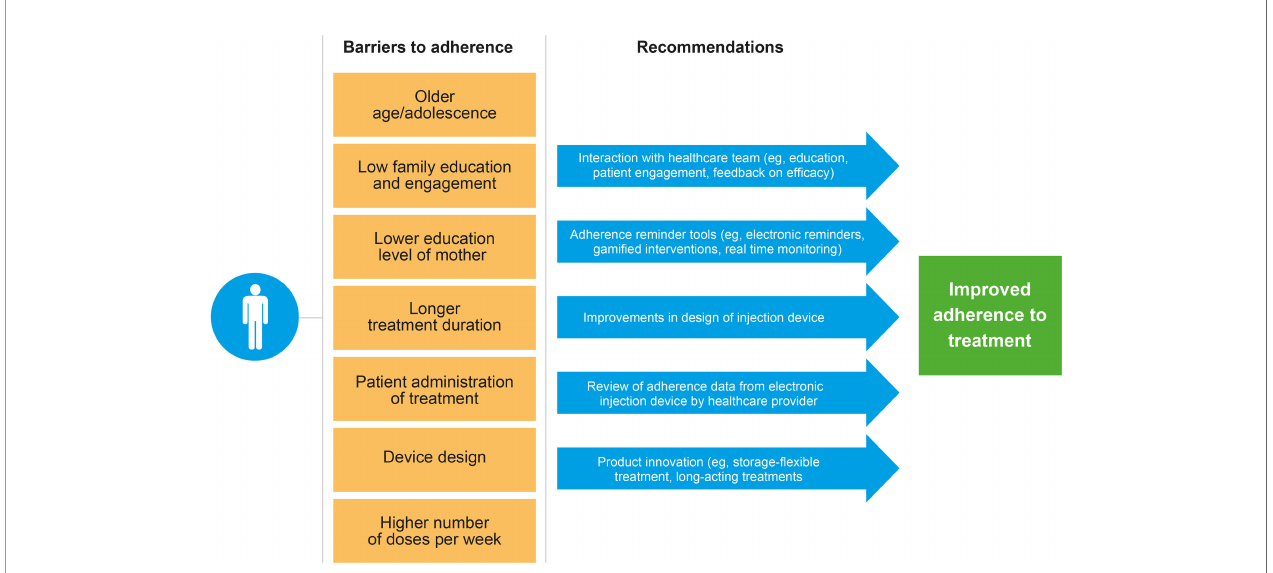
FIGURE 5 | Barriers to adherence and recommendations for improving adherence (identi fi ed in the included